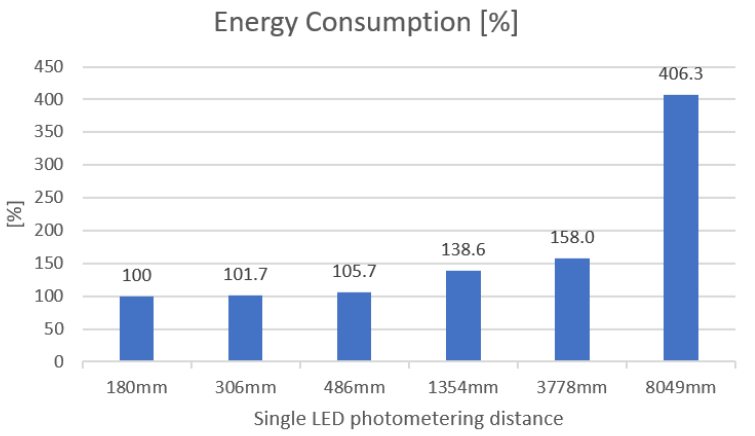
Figure 10. The comparison of energy consumption for an installation lighting a 10-km road. Different photometric distances of individual LEDs installed in the luminaire were used for the compari- son.